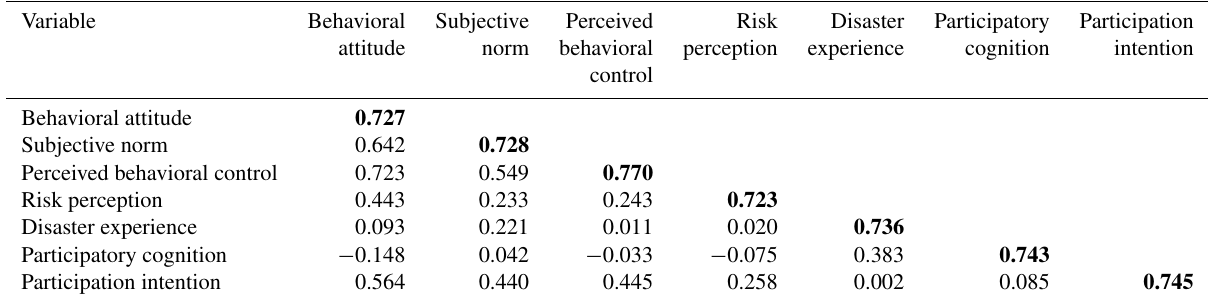
Table 5. Discriminant validity of the latent variables. The bold font values on the diagonal represent the square root of AVE. Variable